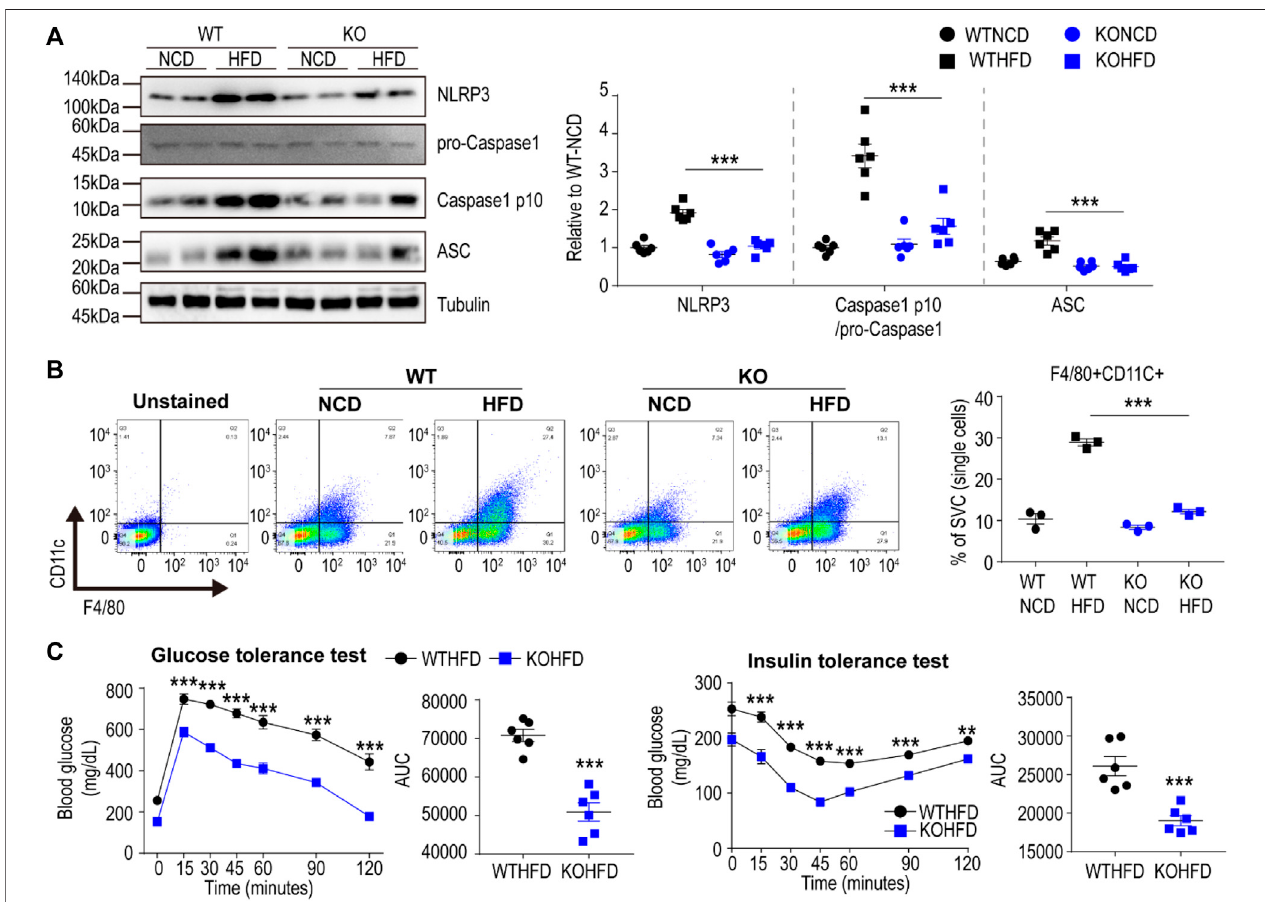
FIGURE 6 | Macrophage-speci fi c Cx43 KO protected mice from HFD induced metabolic dysfunction (A) Immunoblot analysis of gonadal white adipose tissue (gWAT) of WT and Cx43 MKO mice fed with normal chow diet (NCD) or high-fat diet (HFD) for 8 weeks (n = 6). Signi fi cant effects of genotype (NLRP3: p < 0.0001, Caspase1 p10: p < 0.0001, ASC: p < 0.0001) and signi fi cant effects of diet (NLRP3: p < 0.0001, Caspase1 p10: p = 0.0001, ASC: p = 0.0006) were observed. Signi fi cant differences between WT HFD and KO HFD groups were determined by Bonferroni post hoc tests (B) Flow cytometric analysis of SVCs obtained from gWAT ofWT and Cx43 MKO mice fed withNCD or HFD for 8weeks (n=3). Signi fi canteffects ofgenotype ( p < 0.0001) and diet( p < 0.0001) wereobserved. Signi fi cant differencesbetweenWTHFDandKOHFDgroupsweredeterminedbyBonferroniposthoctests (C) GlucosetoleranceandinsulintolerancetestsofWTandCx43MKO micefedwithHFDfor8weeks(n=6).Two-wayANOVAwithBonferroniposthoctestswasusedinA-B.Unpaired,two-tailedt-tests(** p < 0.01,*** p < 0.001)wereused in C. Each point represents biological replicate. Data are presented as mean ±